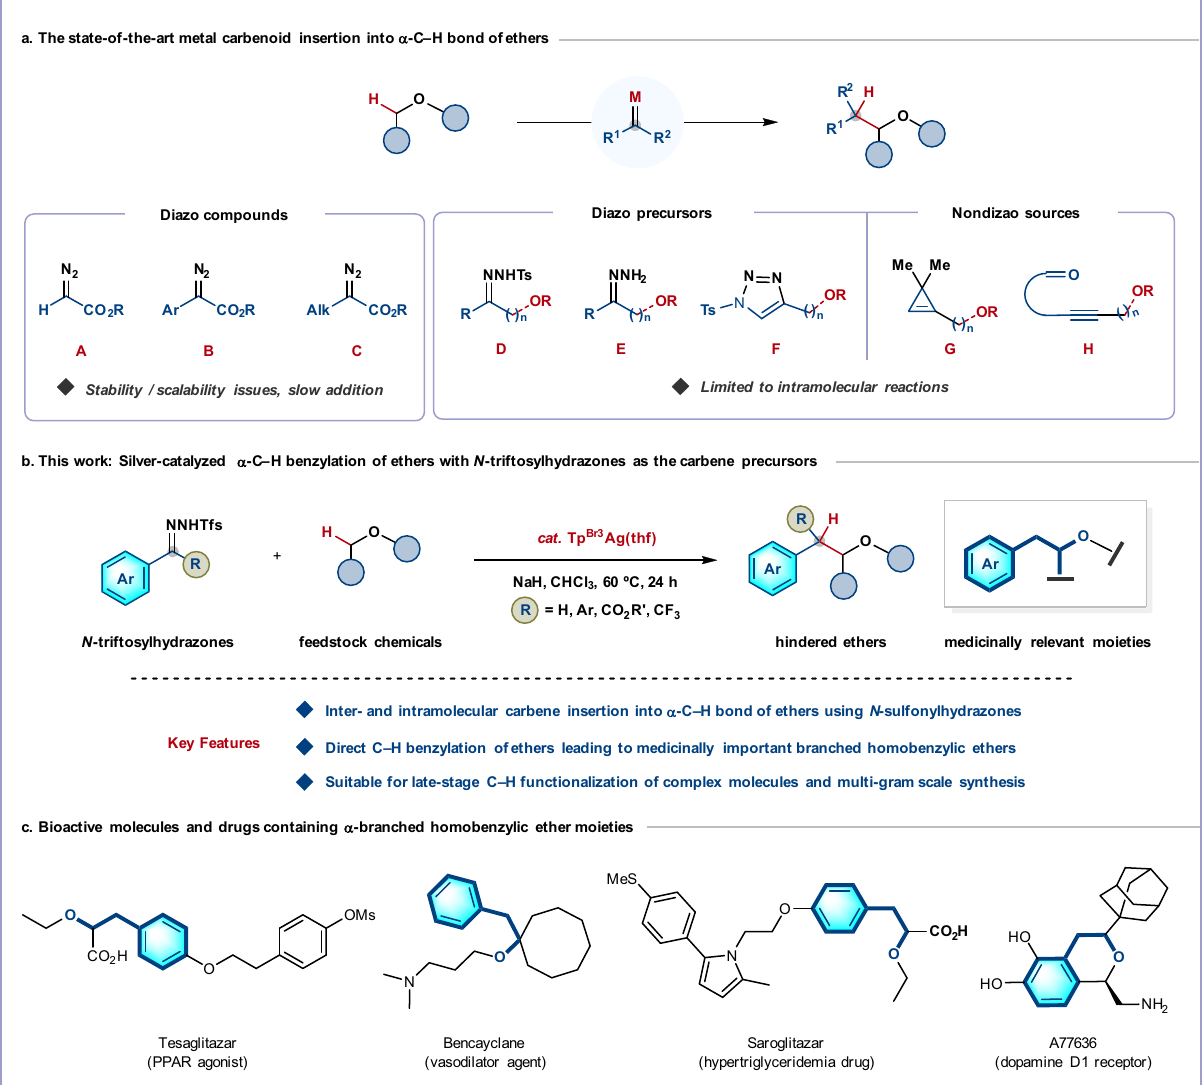
Fig. 1 Inspirations towards the development of carbene insertion into α -C – H bonds of ethers using N -sulfonylhydrazones. a α -C − H functionalization of ethers via carbene insertion process: drawbacks and solutions. b This work: Silver-catalyzed α -C – H insertion reactions of ethers with N -triftosylhydrazones for the synthesis of medicinally relevant branched homobenzylic ethers. c Representative drugs demonstrating the ubiquity of branched homobenzylic ether motifs in bioactive molecules. Ar, aryl; Alk, alkyl; Tfs, triftosyl; thf, tetrahydrofuran; Ms,